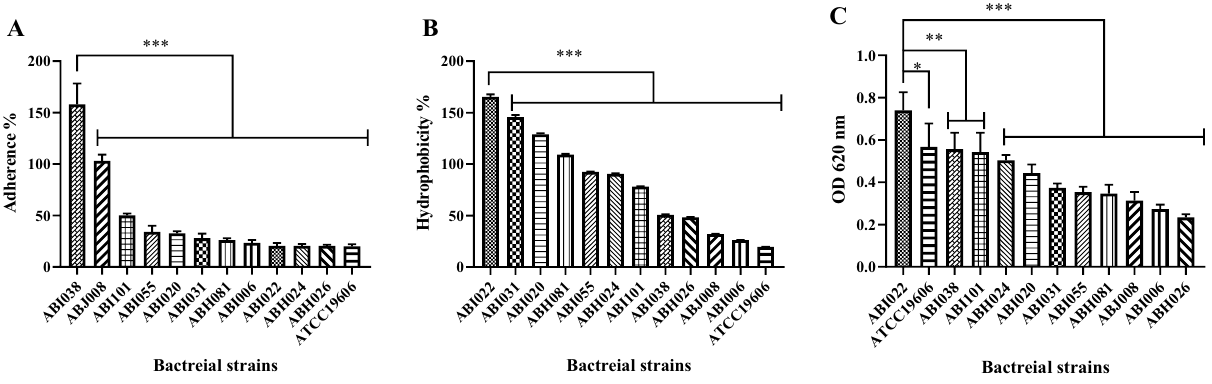
Figure 2. Adherence to A549, hydrophobicity, and biofilm formation assays results for clinical isolates of Acinetobacter baumannii . ( A ) A549 monolayer cells (10 5 cell/mL) were incubated with A. baumannii isolates (10 6 CFU/mL) for 3 h. ABI038 isolate was significantly more adherent than other isolates and A. baumannii ATCC19606 (control strain). ( B ) Cell surface hydrophobicity of isolates was measured using Microbial Adhesion to Hydrocarbon. Adherence to p-xylene by ABI022 isolate was significantly different the adherence by other clinical isolate and control strain. ( C ) Quantitative analysis of biofilm formation by A. baumannii isolates was determined by a microtiter-plate assay. The clinical ABI022 formed a higher biofilm in comparison with other clinical isolates ( p < 0.01, p < 0.001) and A. baumannii ATCC19606 ( p < 0.05). Data are shown as mean ± SD and statistical differences determined by one-way ANOVA and Dunnett’s correction (*** p < 0.001, ** p < 0.01, * p < 0.05).